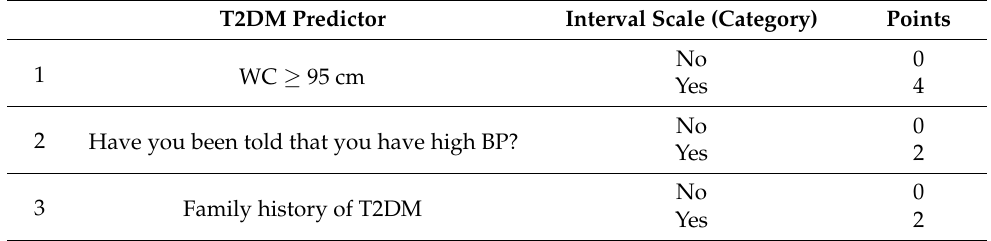
No 0 Yes 4 No 0 Yes 2 No 0 Yes